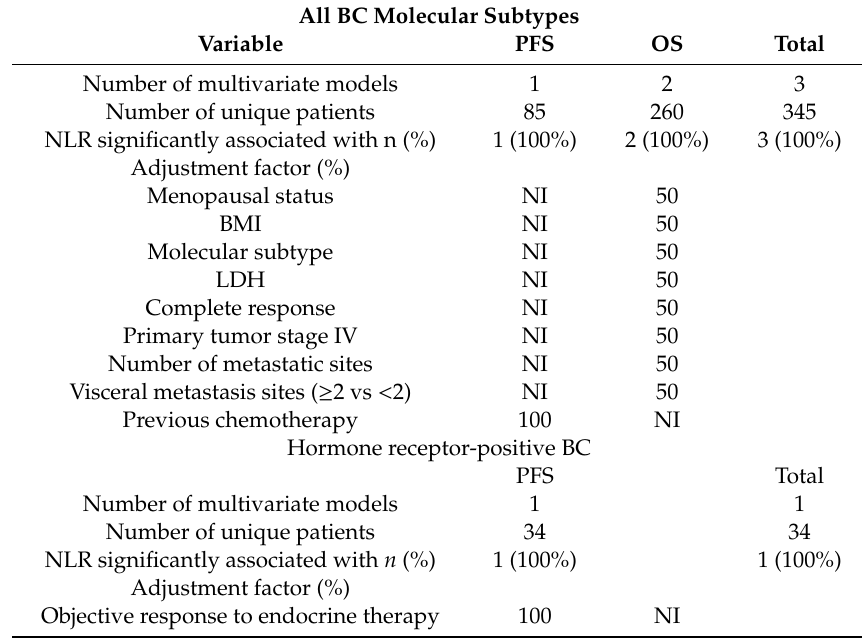
Table 6. Multivariate models (results and adjustment factors) for patients with metastatic breast cancer. All BC Molecular